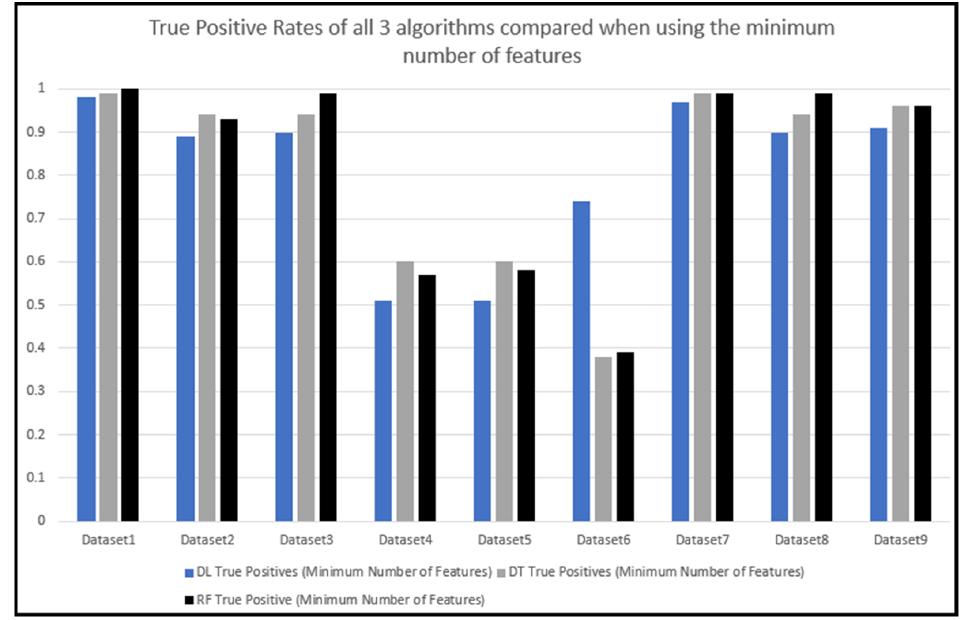
Figure 15. True positive rates compared for all three algorithms when using the minimum number of features.